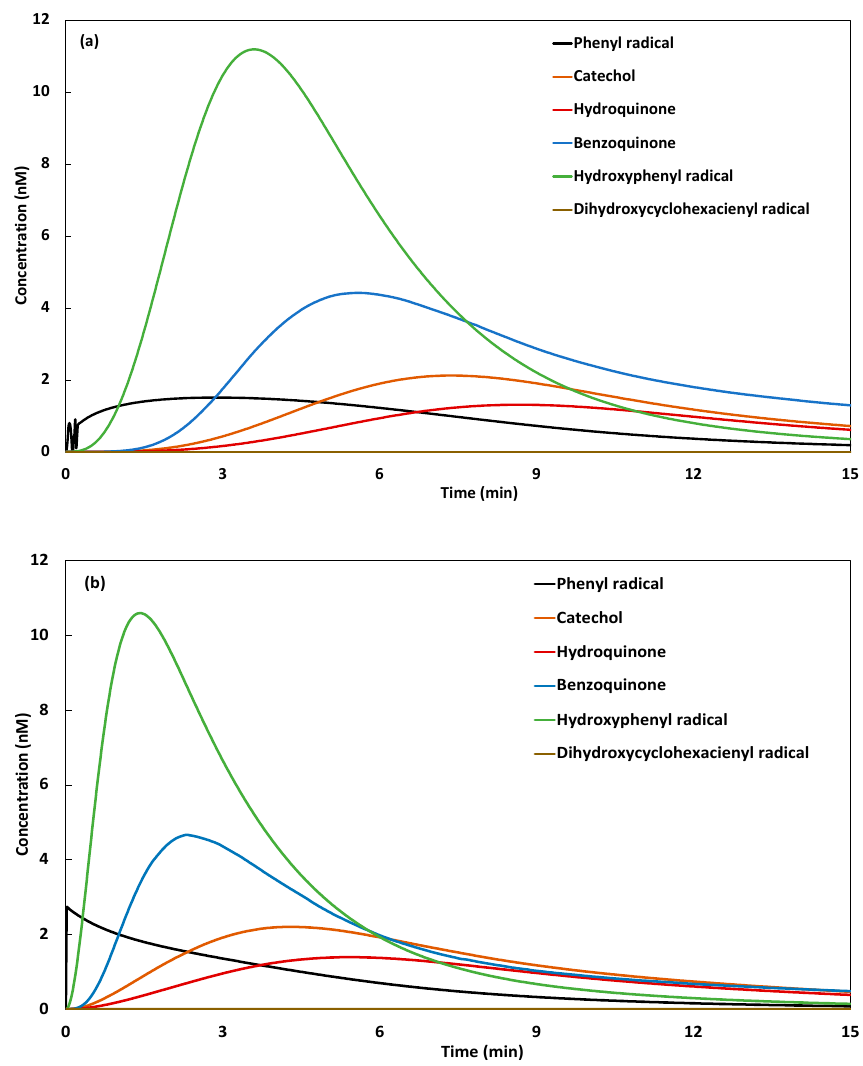
Figure 7. Kinetics of the formation of intermediate species from the degradation of phenol in the Galvano-Fenton process ( a ) and the Galvano-Fenton process with pre-immersion time ( b ). The adopted mechanism of phenol degradation assumes the formation of all of the known intermediates until total mineralization. Accordingly, through the simulations de- picted in Figure 7a,b, within 15 min, the adopted mechanism leads to the complete degra- dation of phenol and the total disappearance of all the intermediate species, revealing the apparition of mineral products as per reactions 42, 43, 45, 47, 48, and 49 in Table 1. Figure